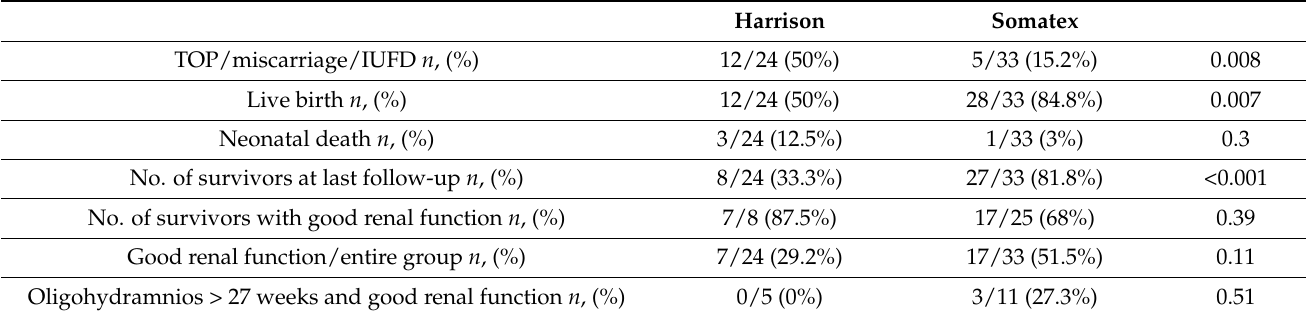
Table 2. Outcome by type of